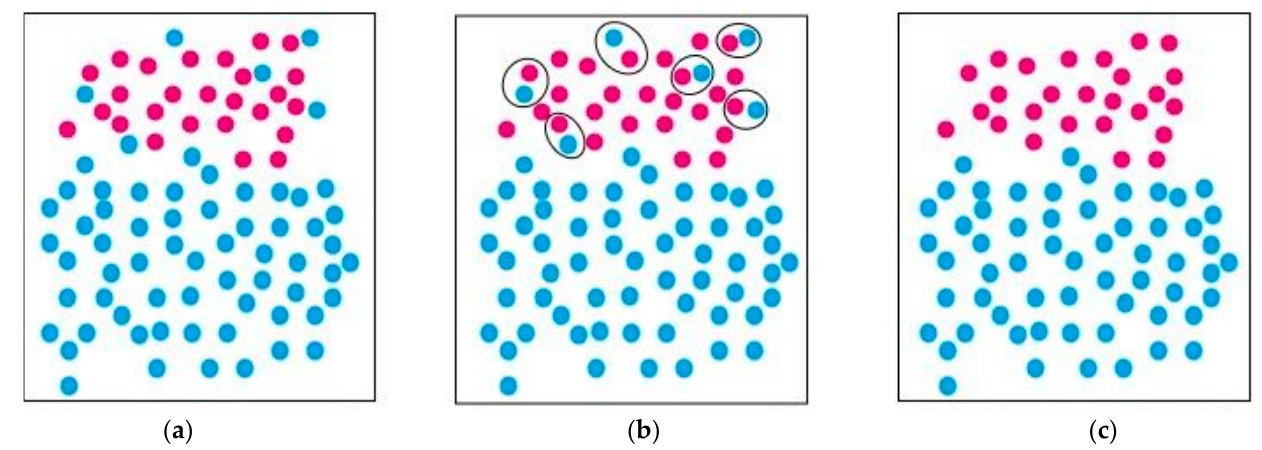
Figure 6. Illustration of Tomek Links. The distance between the two classes widens as the samples of the majority class of the pairs forming TLs are eliminated, resulting in a more evenly distributed dataset. ( a ) Original Distribution of Data, ( b ) Providing the Tomek Links, ( c ) Removing the links. One-Sided Selection (OSS)